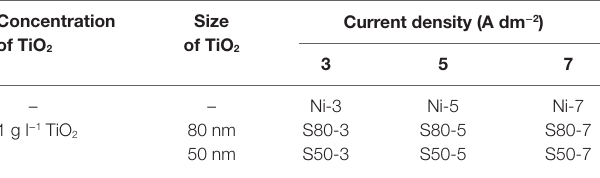
TaBle 3 | nomenclature of pure ni and ni–TiO 2 nanocomposite